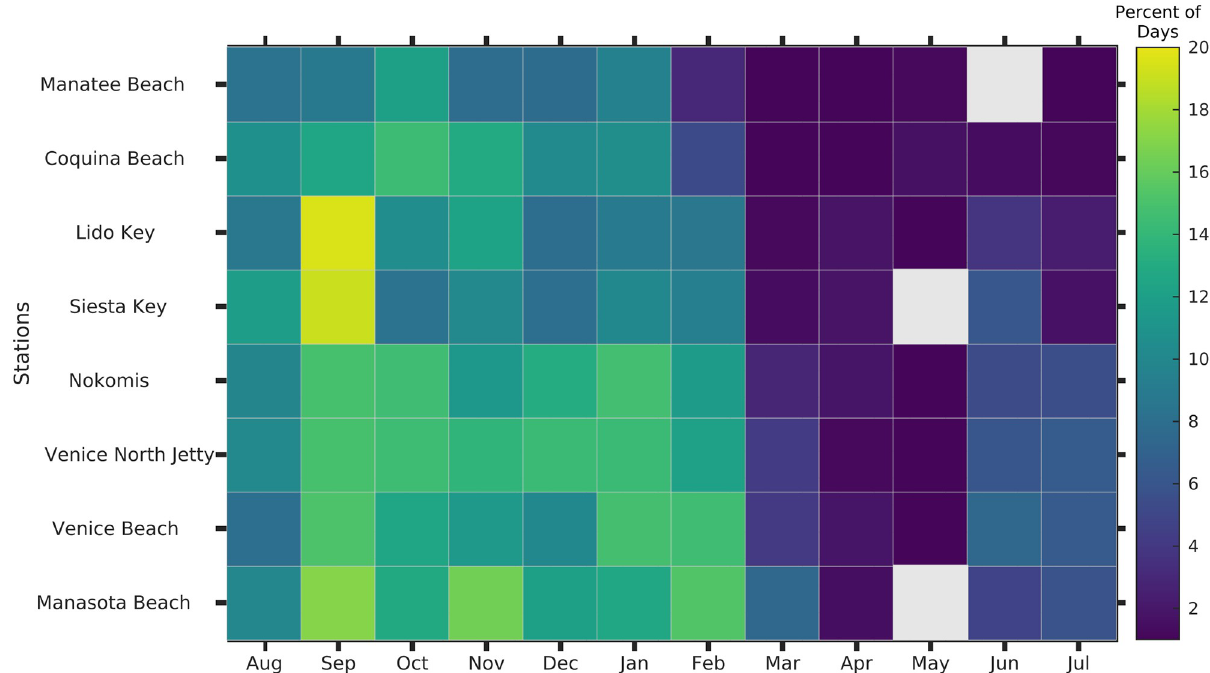
Fig 8. Monthly (seasonal) climatology of the frequency of respiratory irritation. The frequency is the percentage of days with respiratory irritation observed at each beach for each of the twelve months over the data set from 2006–2019. Stations are ordered from north at top to south at bottom (locations in Fig 1). Gray color indicates months when the beach did not have detectable respiratory